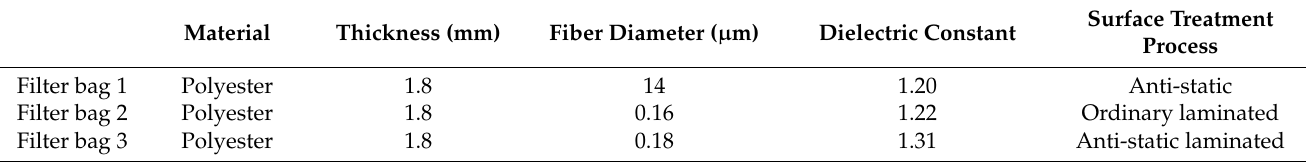
Figure 2. SEM micrographs of three types of filter bags: ( a ) filter bag 1; ( b ) filter bag 2; ( c ) filter bag 3. Table 1. The testing parameters of the three filter bags.